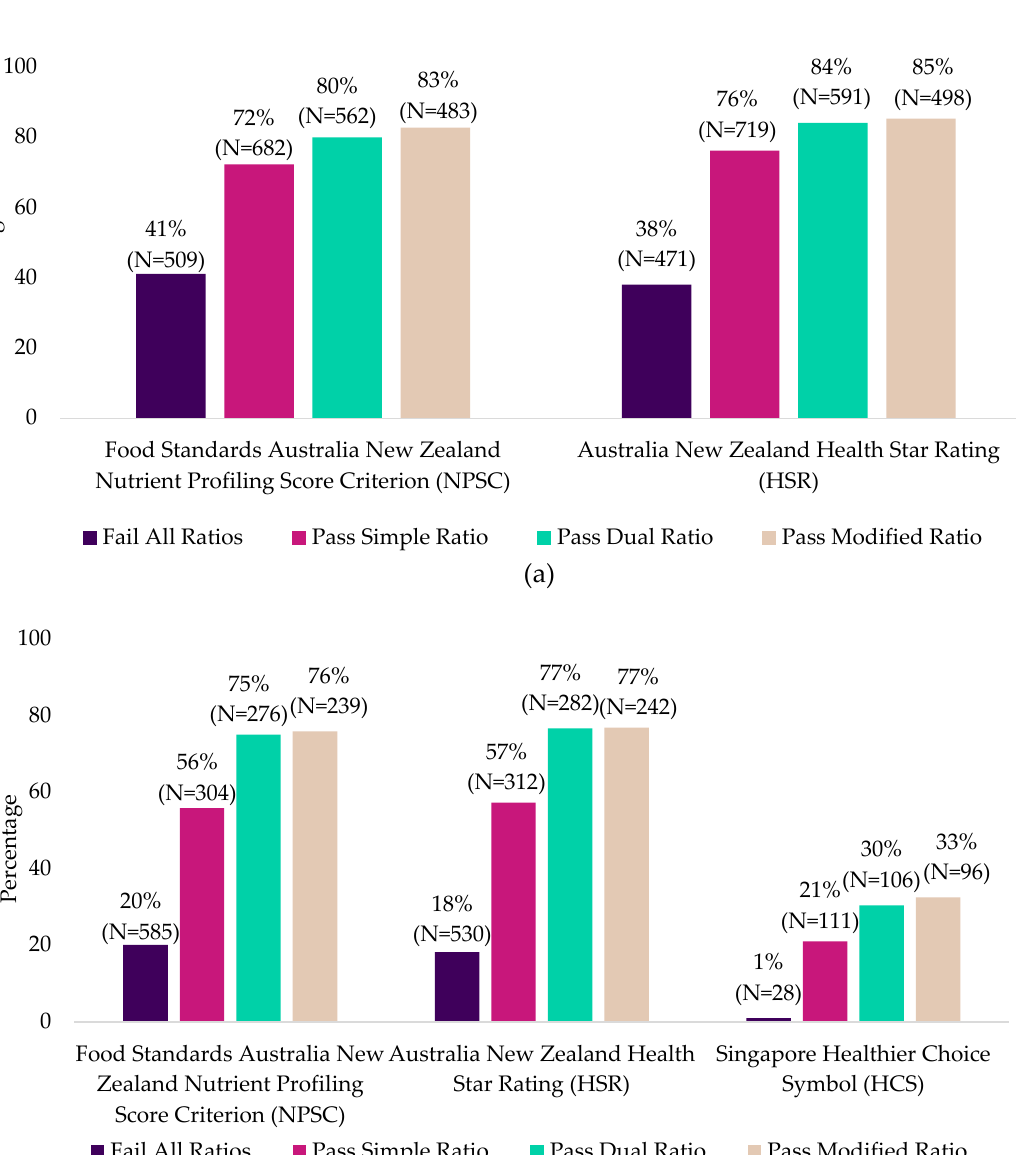
Figure 4. Percentage of carbohydrate-based packaged foods from ( a ) Mintel Australia and ( b ) Mintel Asia that passed or failed the three metrics and met the respective national nutrient profiling models as a nutritious product.